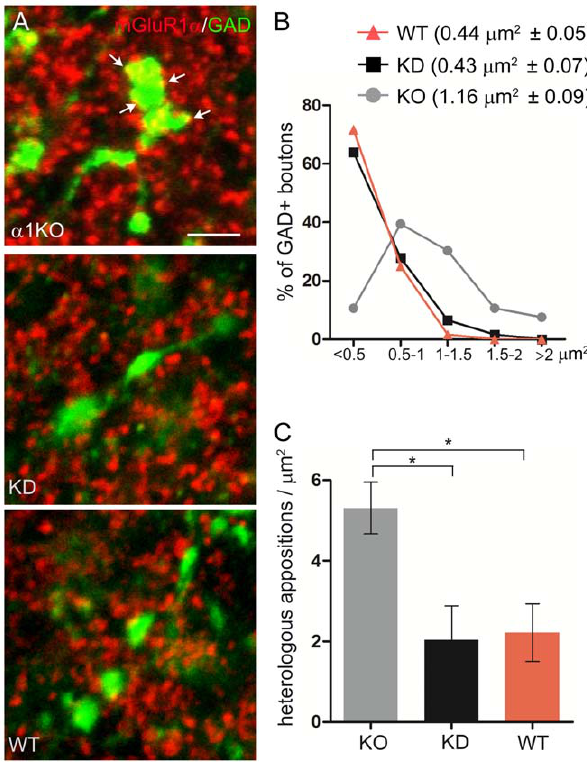
Figure 6. Absence of heterologous synapses in the cerebellum of c 2 KD mice. A, Representative confocal images after double labeling for mGluR1 a (a marker of PC spines) and GAD65. In global a 1 knockout mice (upper panel), large GABAergic axon terminals make multiple contacts with PC spines (arrows). In c 2 KD (middle panel) and WT mice (lower panel), GAD65-positive terminals have a smaller size and are less frequently found in close apposition with spines. B, Distribution of GAD65-positive boutons in the molecular layer of total a 1 knockouts, c 2 KD and WT mice based on size. The average area ( 6 SEM) is indicated. In total a 1 knockout mice, GABAergic axon terminals are significantly larger than in the other groups ( a 1 KO vs WT, p=0.0016; a 1 KO vs c 2 KD, p=0.0008; c 2 KD vs WT, p=0.9348; unpaired t -test; n=4 mice per group). C, The density of heterologous contacts between GAD65-positive terminals and PC spines is signifi- cantly higher in global a 1 knockout mice compared with both c 2 KD and WT mice ( a 1 KO vs WT, p=0.03; a 1 KO vs c 2 KD, p=0.03; c 2 KD vs WT, p=0.8836; unpaired t -test; n=3 mice per group). Scale bar: 2 m